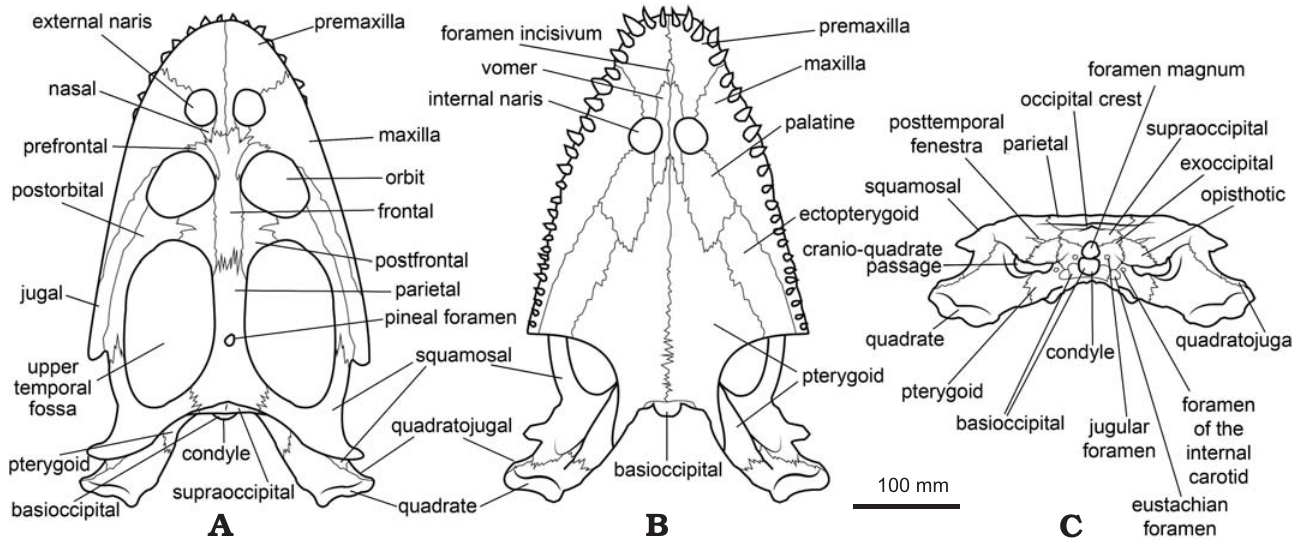
Fig. 6. Schematic reconstruction of an idealized skull of Simosaurus gaillardoti Meyer, 1842, in dorsal ( A ), ventral ( B ), and occipital ( C )